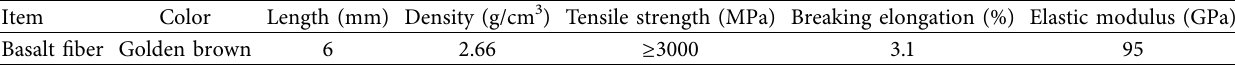
Table 7: Physical properties of the basalt fiber.